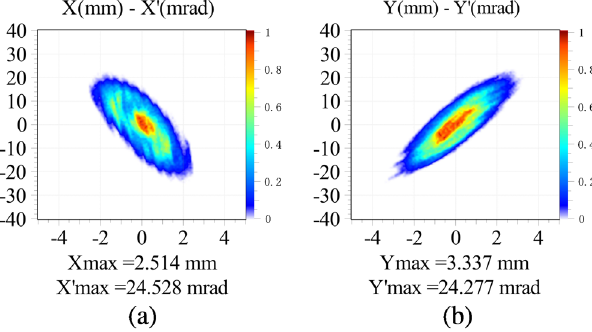
FIG. 9. Measured phase spaces at the exit of the RFQ: (a) x – x 0 plane; (b) y – y 0 plane.